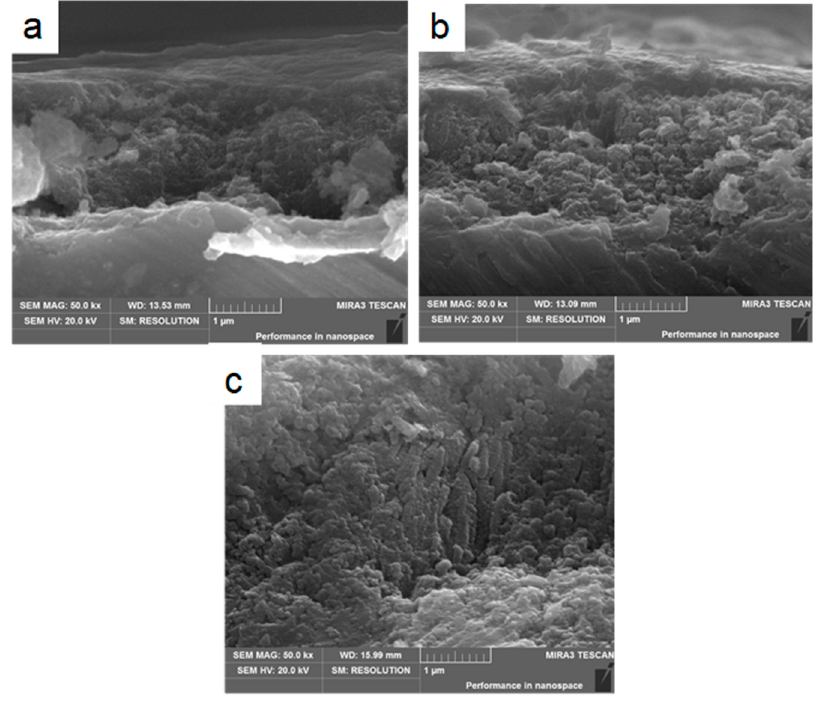
Figure 8. ( a ) SEM image of cross-section of HA coating on titania nanotubes anodized at 20 V for 3 h, ( b ) 20 V for 6 h, and ( c ) 20 V for 12